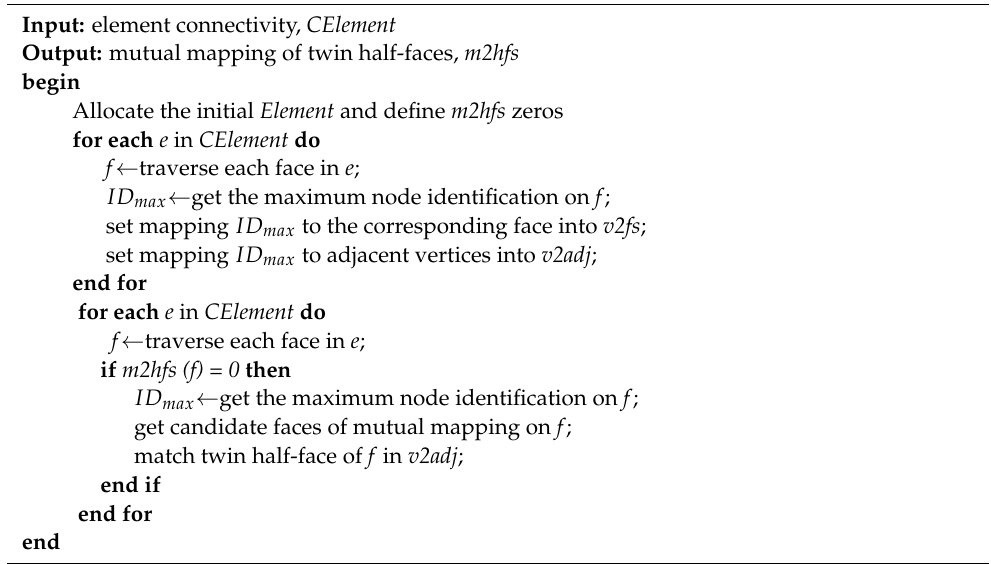
Algorithm 2 implements the mapping between the different dimensional entities.